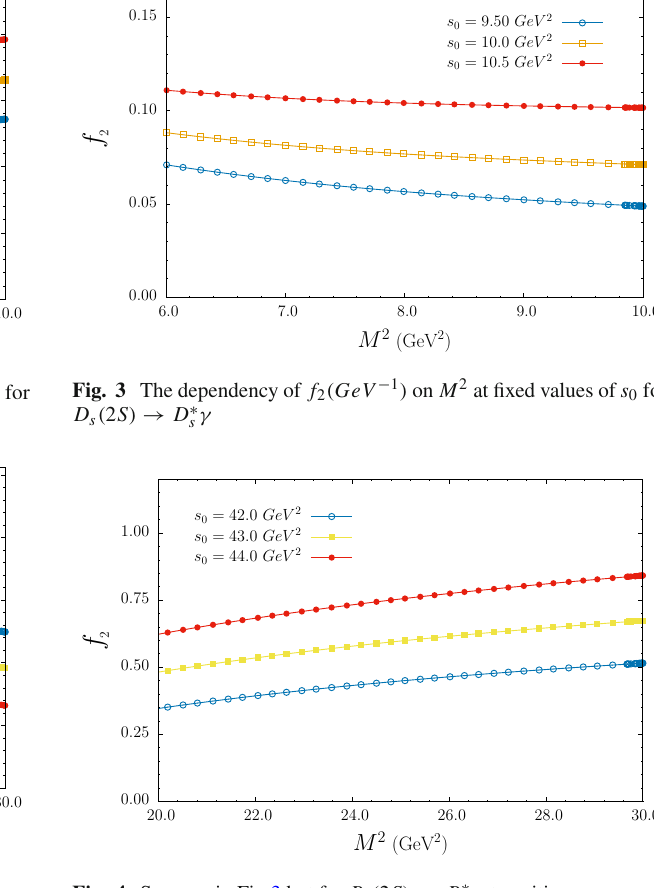
Fig. 4 Same as in Fig.3 but for B s ( 2 S ) → B ∗ s γ transition